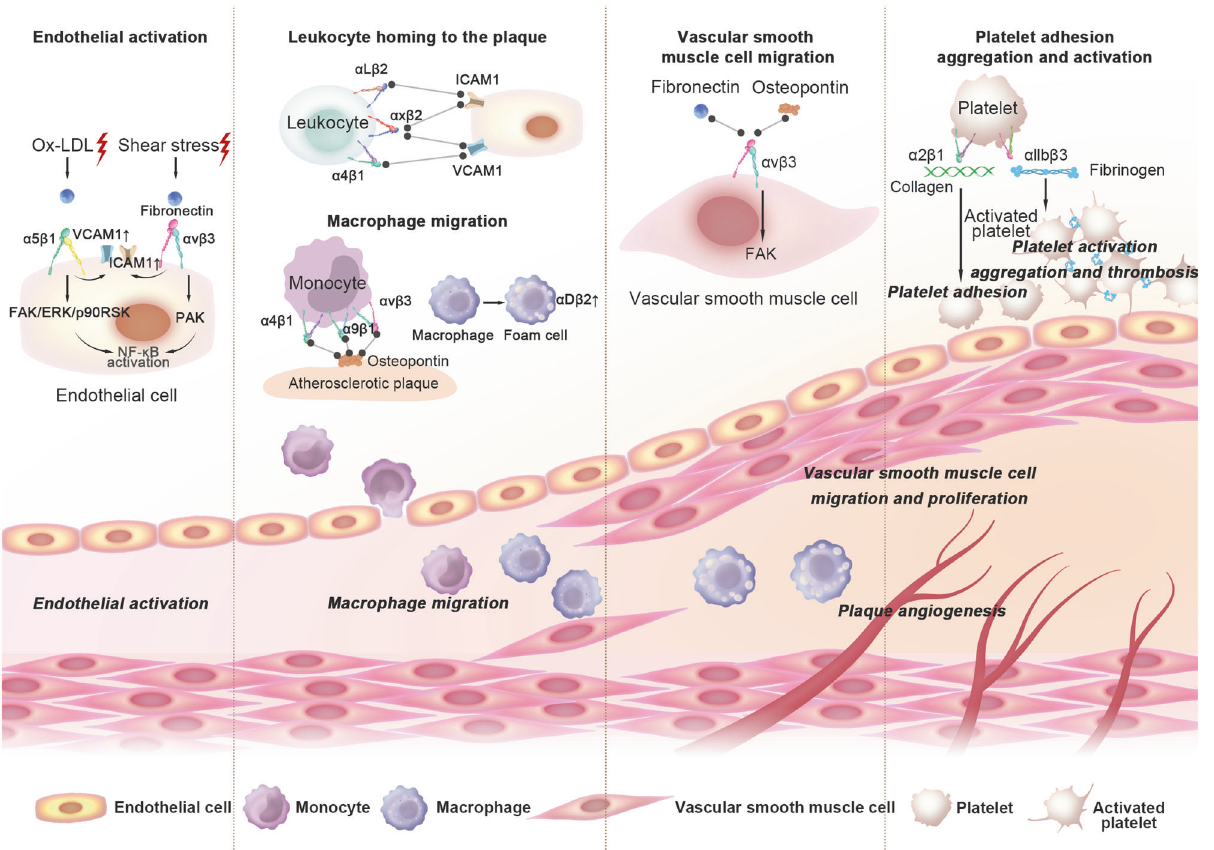
Fig. 7 Main roles of integrins in the process of AS. Integrin signaling can affect multiple processes in AS, including endothelial dysfunction and activation, leukocyte homing to the plaque, smooth muscle cell migration, and thrombosis. In the process of endothelial cell activation, ox-LDL activates α 5 β 1, induces the FAK/ERK/p90RSK pathway and promotes NF- κ B signaling. Shear stress can activate α v β 3 and induce PAK activation by binding to fi bronectin, thereby promoting NF- κ B activation. Both ox-LDL and shear stress generated by blood fl ow mediate the increased expression of proin fl ammatory genes (ICAM-1 and VCAM-1) after integrin ligation. During the process of leukocyte homing to plaques, α x β 2 and α 4 β 1 interact with VCAM-1 on the endothelial cell surface, and α x β 2 and α L β 2 interact with ICAM-1 to promote leukocyte adhesion. Integrins α 4 β 1, α 9 β 1 and α v β 3 on the surface of monocytes interact with osteopontin, which is expressed in atherosclerotic plaques, to promote monocyte migration and survival. Integrin α D β 2 is upregulated during macrophage foam cell formation. During vascular smooth muscle cell migration, α v β 3 binding with fi bronectin, osteopontin, etc., mediates FAK activity and drives migration. In the process of thrombosis, integrins α 2 β 1 and aIIb β 3 on platelets are involved in platelet adhesion, activation, aggregation, and